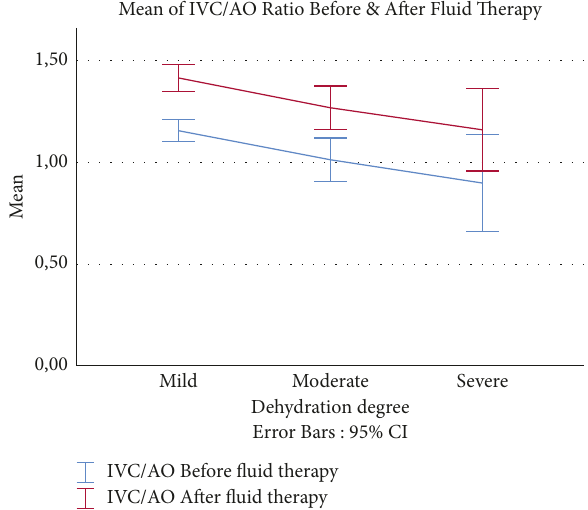
Figure 1: The values of IVC/AOs before and after fluid therapy according to the degree of